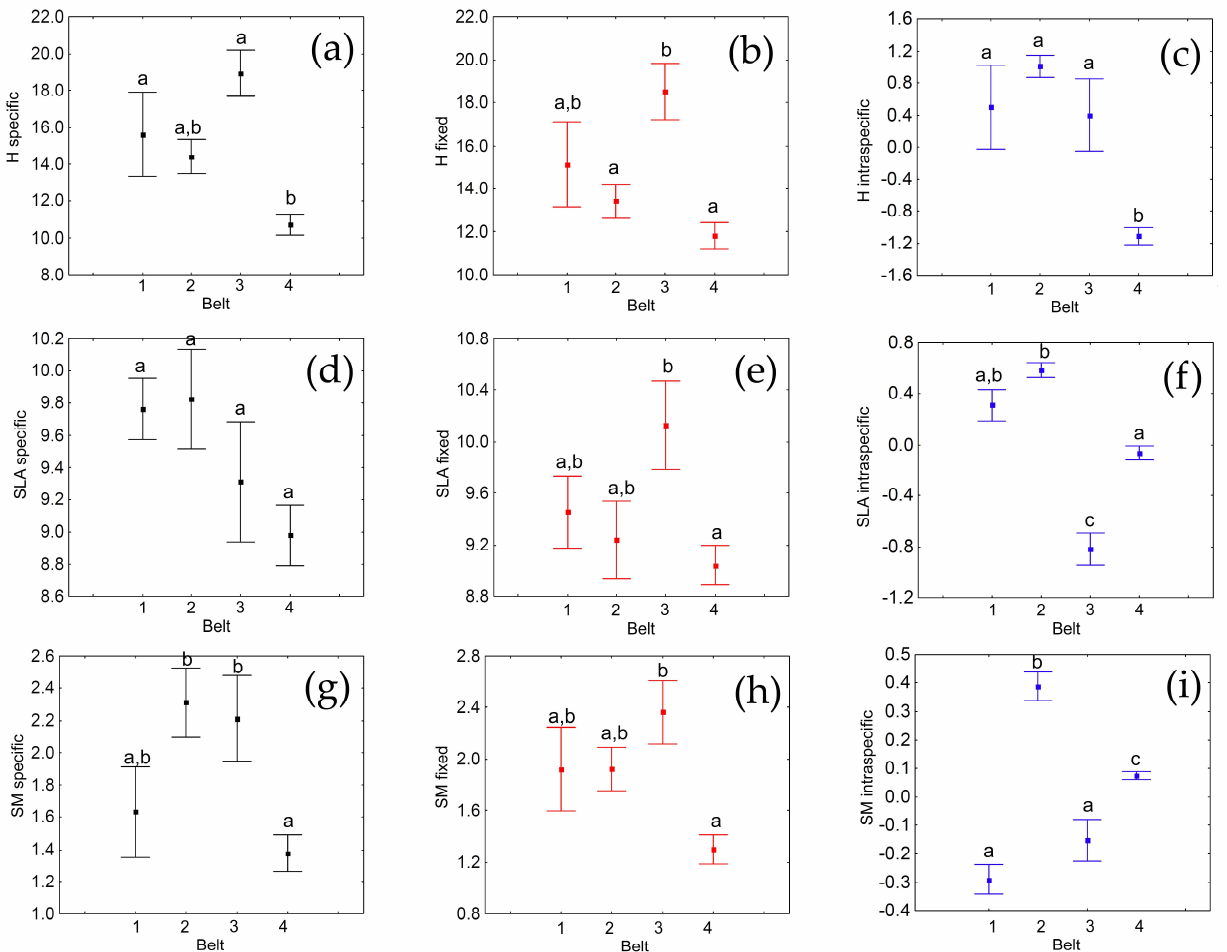
Figure 1. Averages and standard errors of community-weighted mean (CWM) values in the four elevational belts (elevation: 1, 2, 3, 4) calculated for plant height (H: a , b , c ), specific leaf area (SLA: d , e , f ) and seed mass (SM, g , h , i ), along an elevational gradient in Central Italy. CWMs were calculated for the specific variability ( a , d , g ), the fixed component ( b , e , h ) and the intraspecific variability ( c , f , i ). Letters indicate Tukey honest significant difference (HSD) post-hoc tests at the p < 0.05 level, following ANOVA.